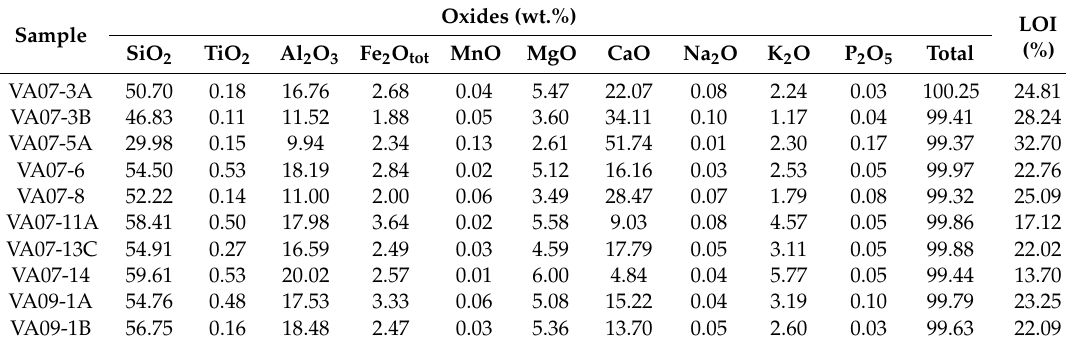
Table 1. Anhydrous weight percentage of oxides from X-ray fluorescence (XRF) analysis of clay samples from Vajont and Loss On Ignition (LOI) content.